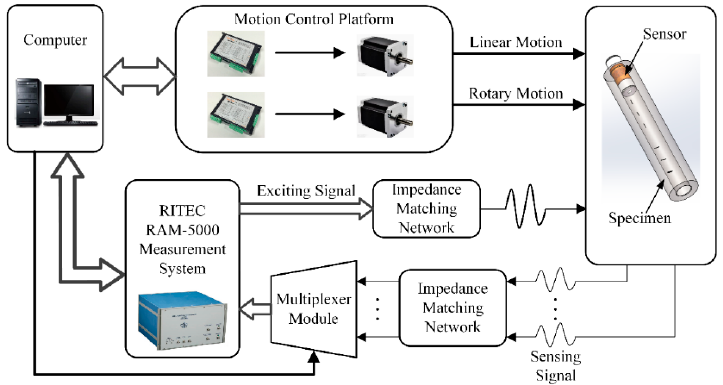
Figure 7. Diagram block of the experimental system.